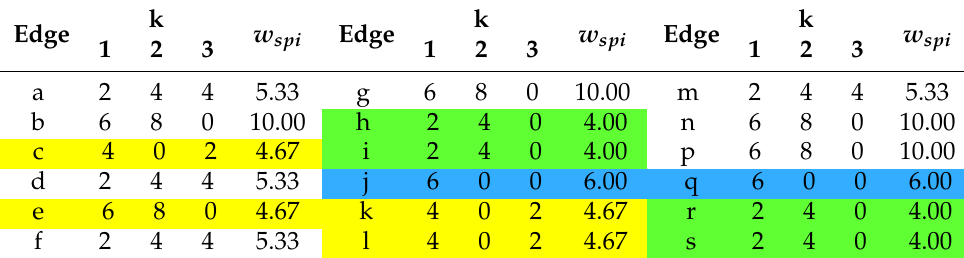
Table 5. Total numbers of uses of specific graph edges in all minimum length paths.